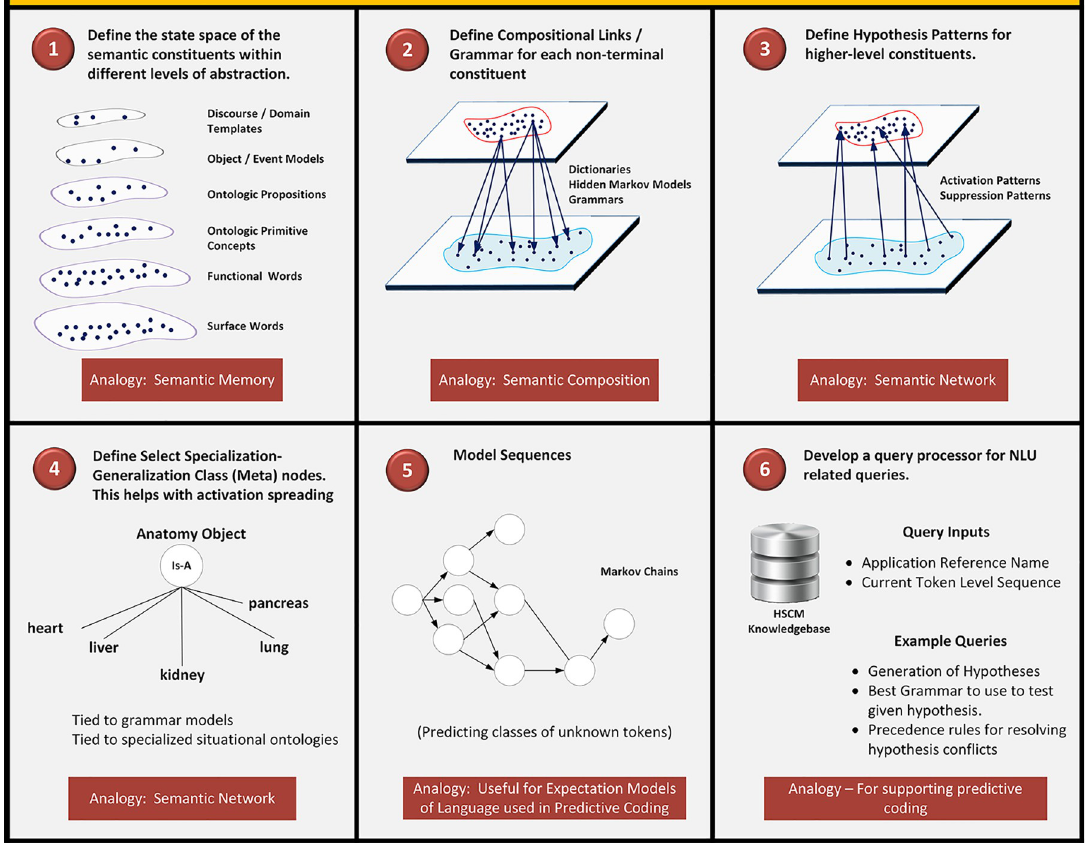
Fig 2. Tasks associated with the construction of the hierarchical compositional semantic model.